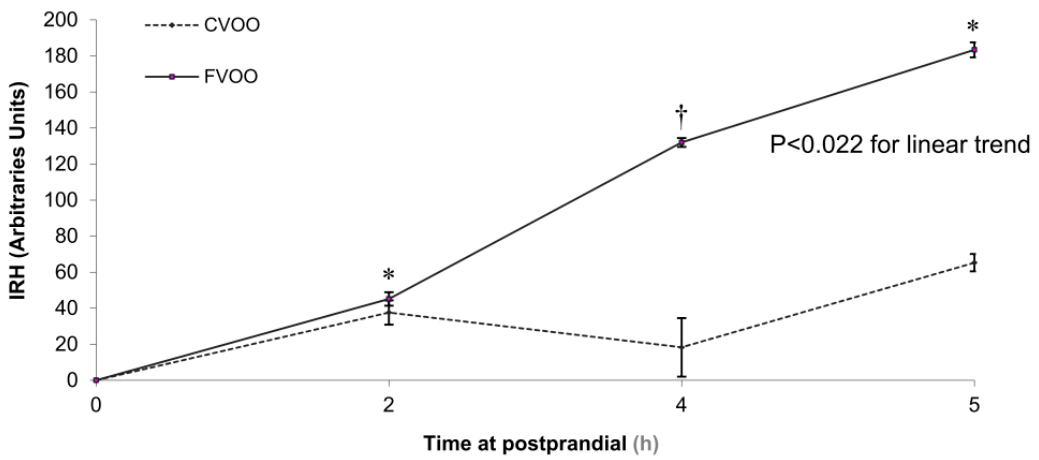
Figure 2. Postprandial time-course changes in ischemic reactive hyperemia (IRH) after ingestion of the different olive oils (OOs). CVOO: control virgin olive oil; FVOO: functional virgin olive oil enriched with its phenolic compounds (500 ppm). *, P < 0.05 versus baseline; †, P < 0.05 versus VOO at the same time-point. Figure reproduced with permission from Valls et al. [85].